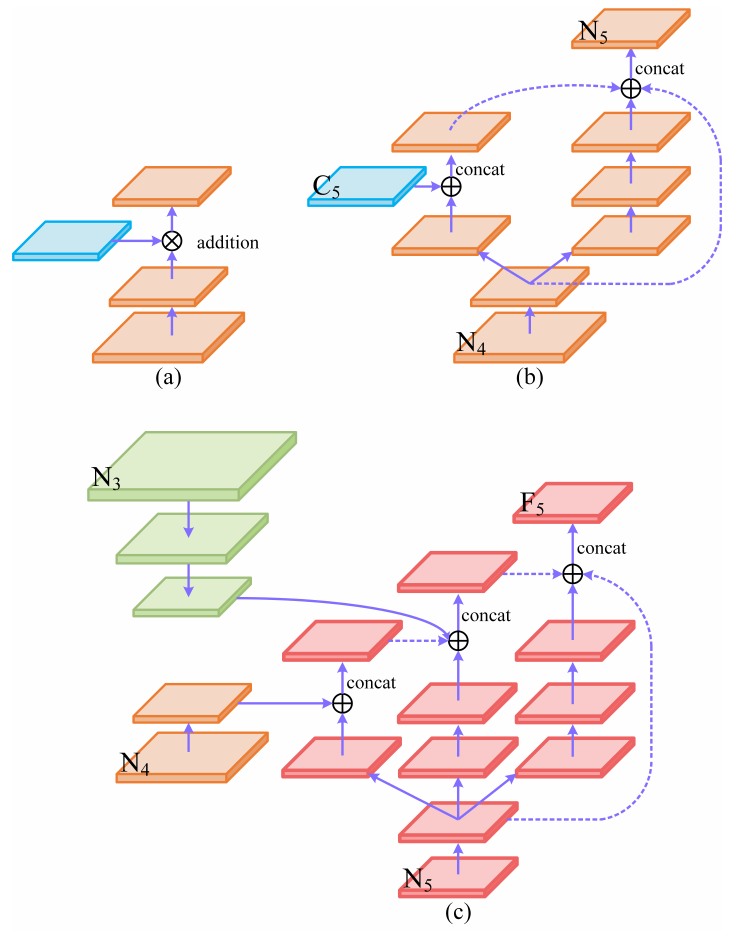
Figure 5. Illustration of network design. ( a ) PANet; ( b ) our SC-PANet; ( c ) our SC-fusion